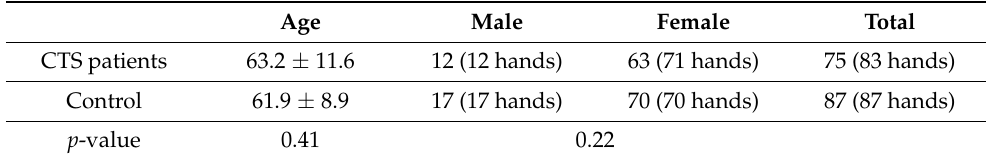
Table 1. Average age and gender of both